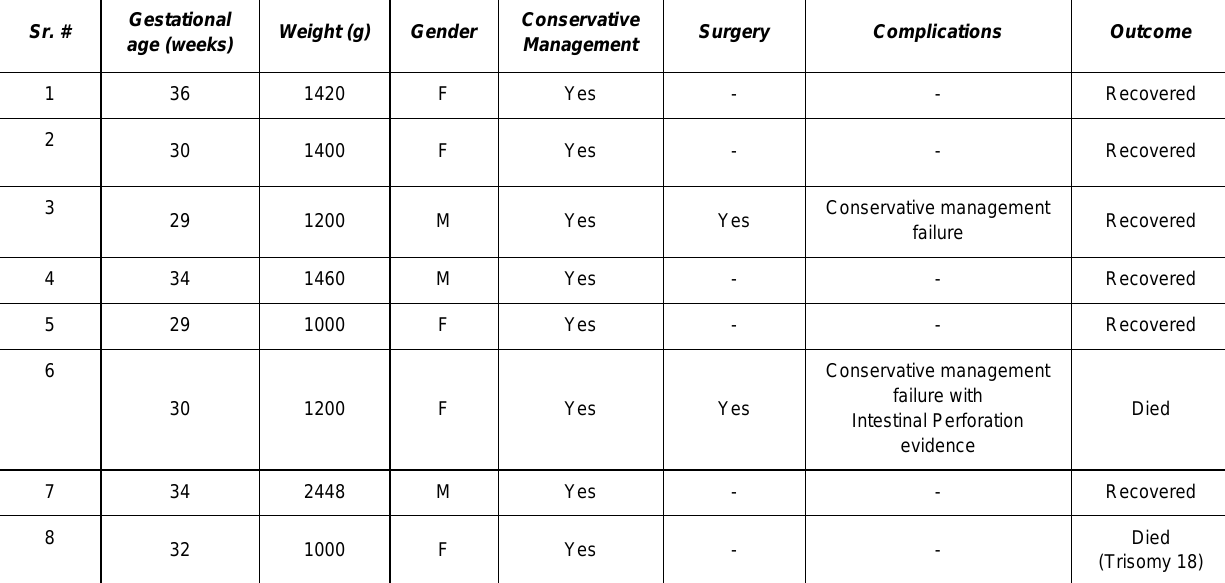
Table 1. Characteristics of